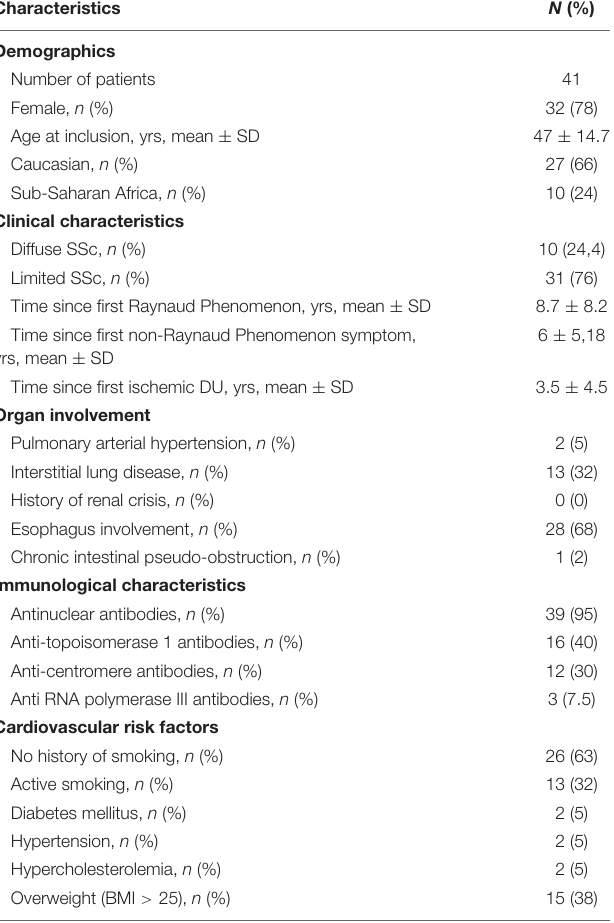
TABLE 1 | Characteristics of 41 patients with SSc. TABLE 2 | Systemic sclerosis features and DUs outcome in patients treated with ≤ 5 days and > 5 days of iloprost infusions: data expressed as number of all lines of iloprost infusions from 41 SSc